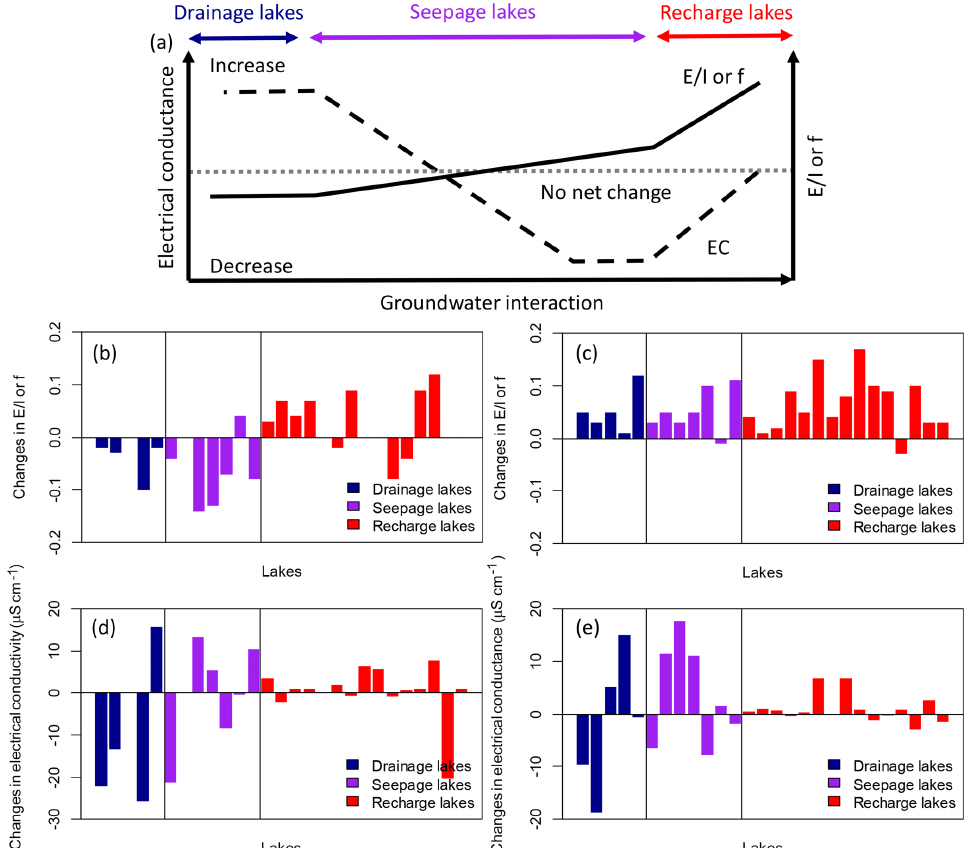
Figure 8. Conceptual model of the relationship between the direction and magnitude of lake E/I or f and EC changes during drier conditions according to lake type, defined by the degree to which lakes interact with groundwater (modified from Webster et al., 1996) (a) . Observed changes in E/I or f between June 2013 and June 2014 ( E/I 2014– E/I 2013) (b) , changes in E/I between August 2014 and June 2014 ( E/I or f August to E/I or f June) (c) , changes in specific conductance between June 2013 and June 2014 (EC 2014–EC 2013) (d) , and changes in electrical conductance between August and June 2014 (EC August–EC June) (e) by lake